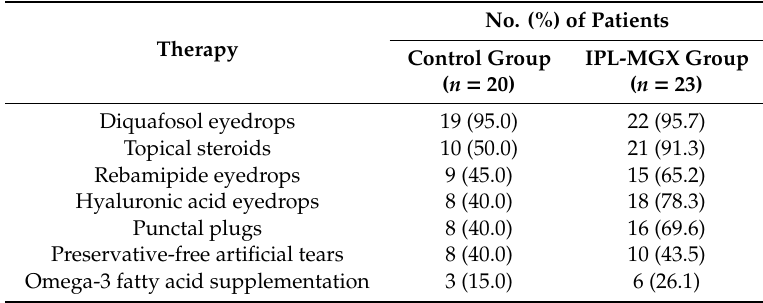
Table 2. Previous therapies for the study patients in the intense pulsed light (IPL)-meibomian gland expression (MGX) and MGX (control)